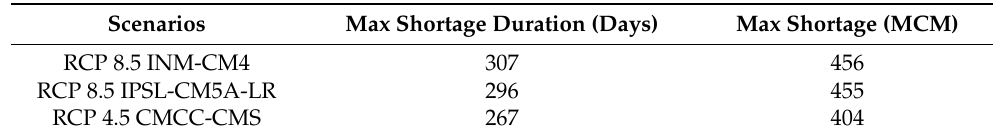
Table 5. A summary table for the final three climate change scenarios with maximum shortage duration (days) and maximum shortage (MCM).